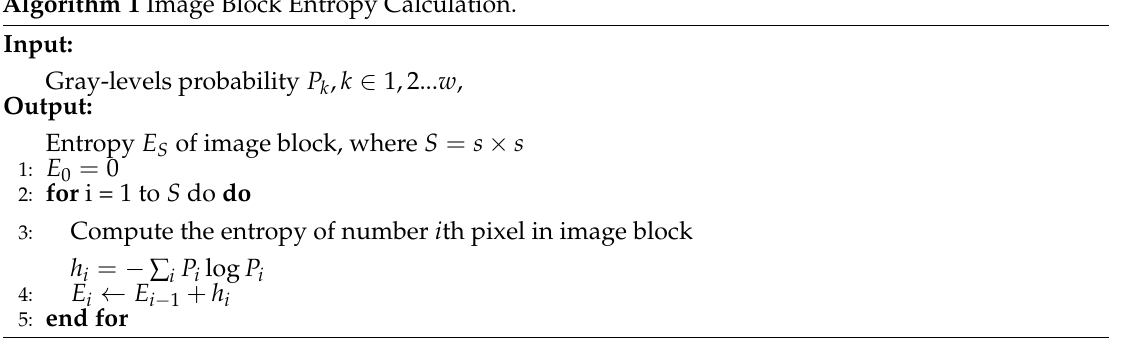
Algorithm 1 Image Block Entropy